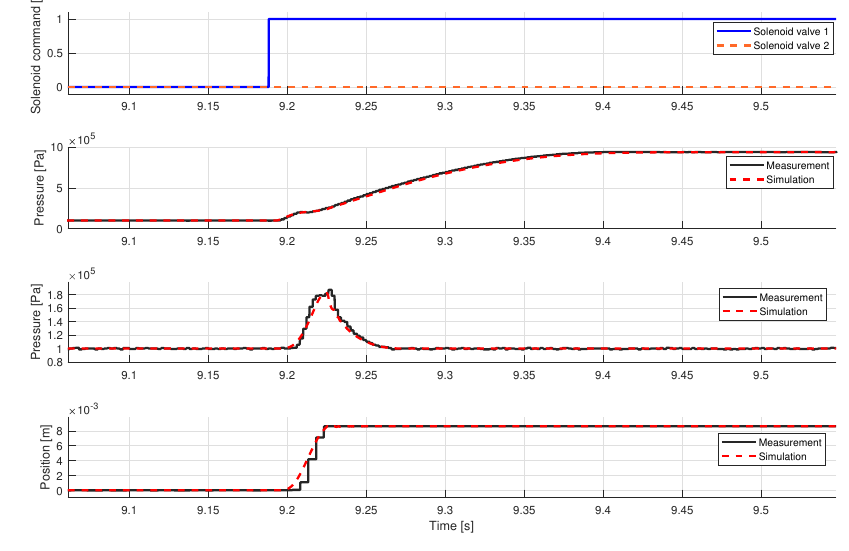
Figure 3. Validation test case—Neutral-to-High gear